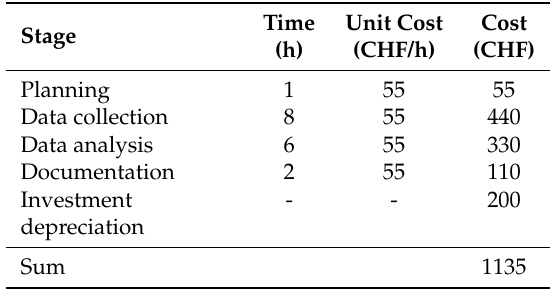
Table 9. Traditional progress and quality measurement